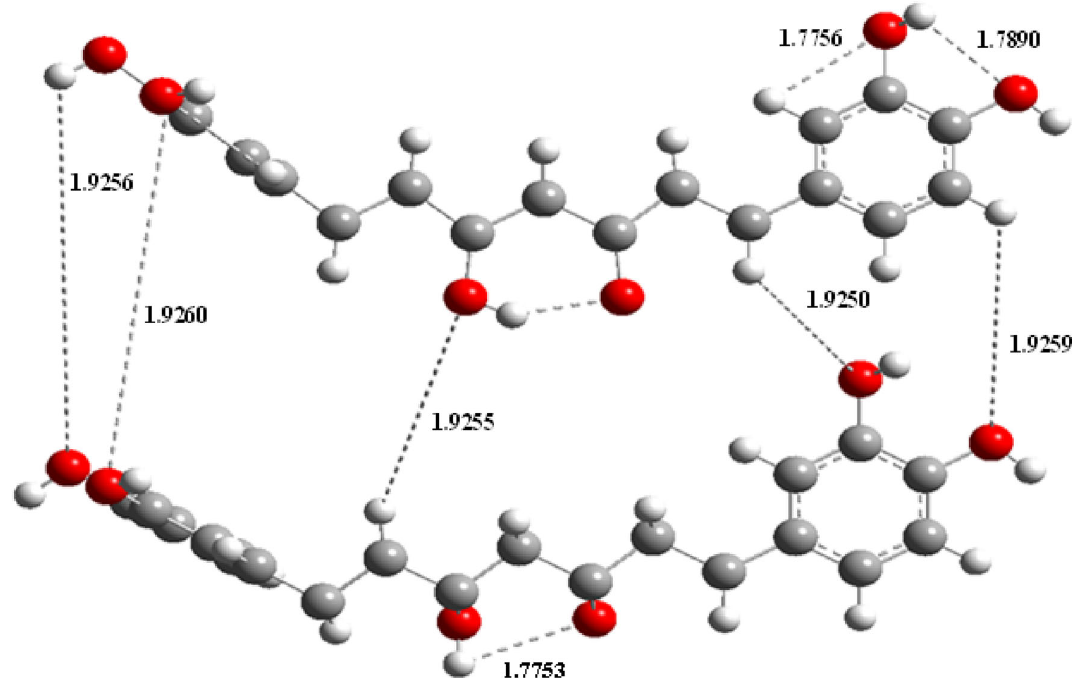
Fig. 2 Optimized dimer molecular structure of